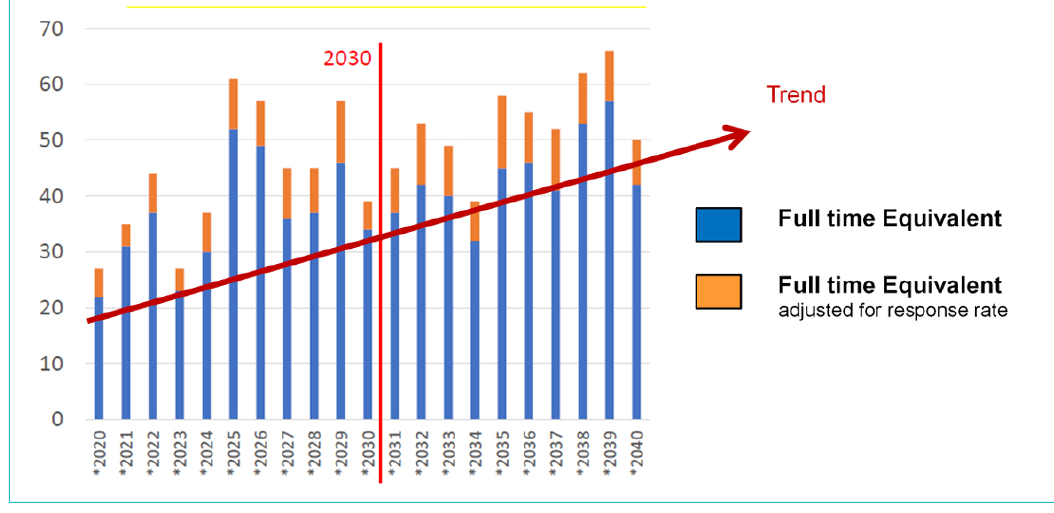
Figure 3: Bar chart of full-time equivalent (FTE) anaesthesiologist positions lost due to retirement over the